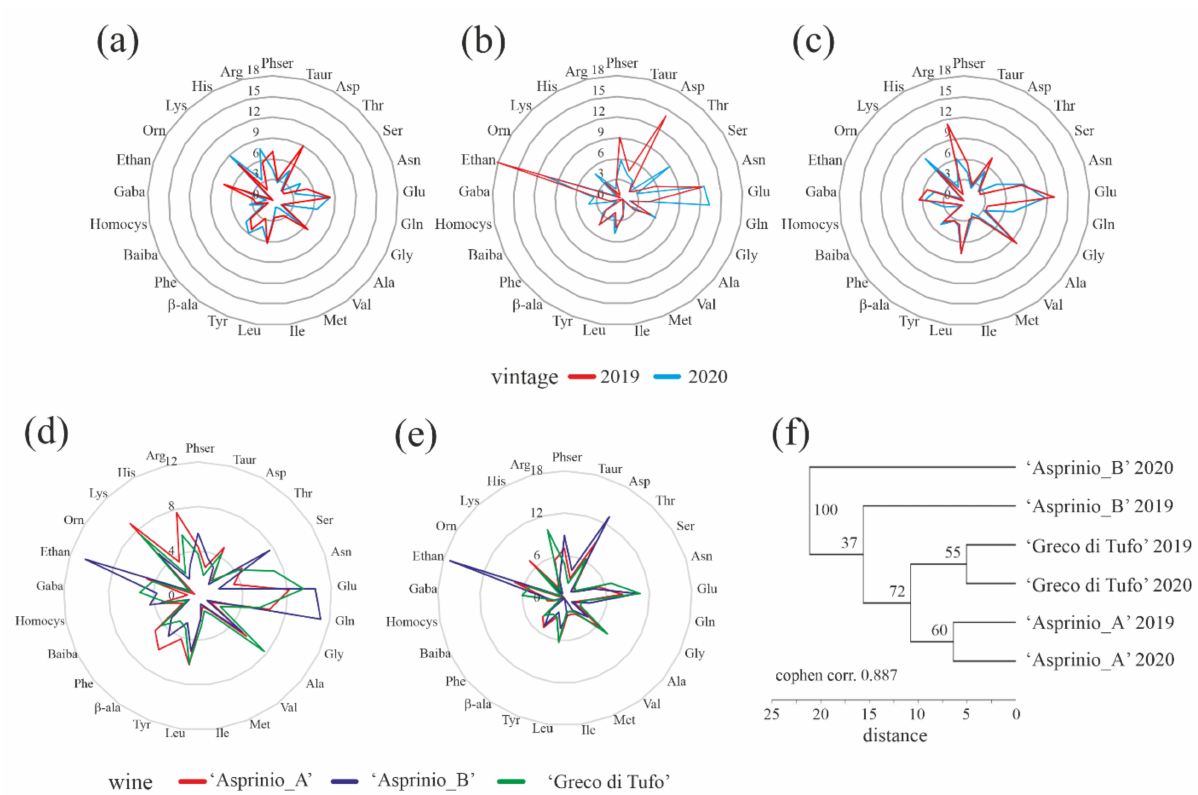
Figure 5. In ( a – c ), radar graph representing the free amino acid profile changes (percentage) in ‘Asprinio_A’, ‘Asprinio_B’ and ‘Greco di Tufo’, respectively, analysed in 2019 and 2020 vintages. In ( d , e ), radar graph representing the free amino acid profile changes of ‘Asprinio_A’, ‘Asprinio_B’ and ‘Greco di Tufo’, respectively, in 2019 or 2020 vintages. In ( f ), dendrogram corresponding to the cluster analysis of free amino acid profiles in ‘Asprinio_A’, ‘Asprinio_B’ and ‘Greco di Tufo’ from 2019 and 2020 vintages. Numbers on the dendrogram are bootstrap values (% of 1000